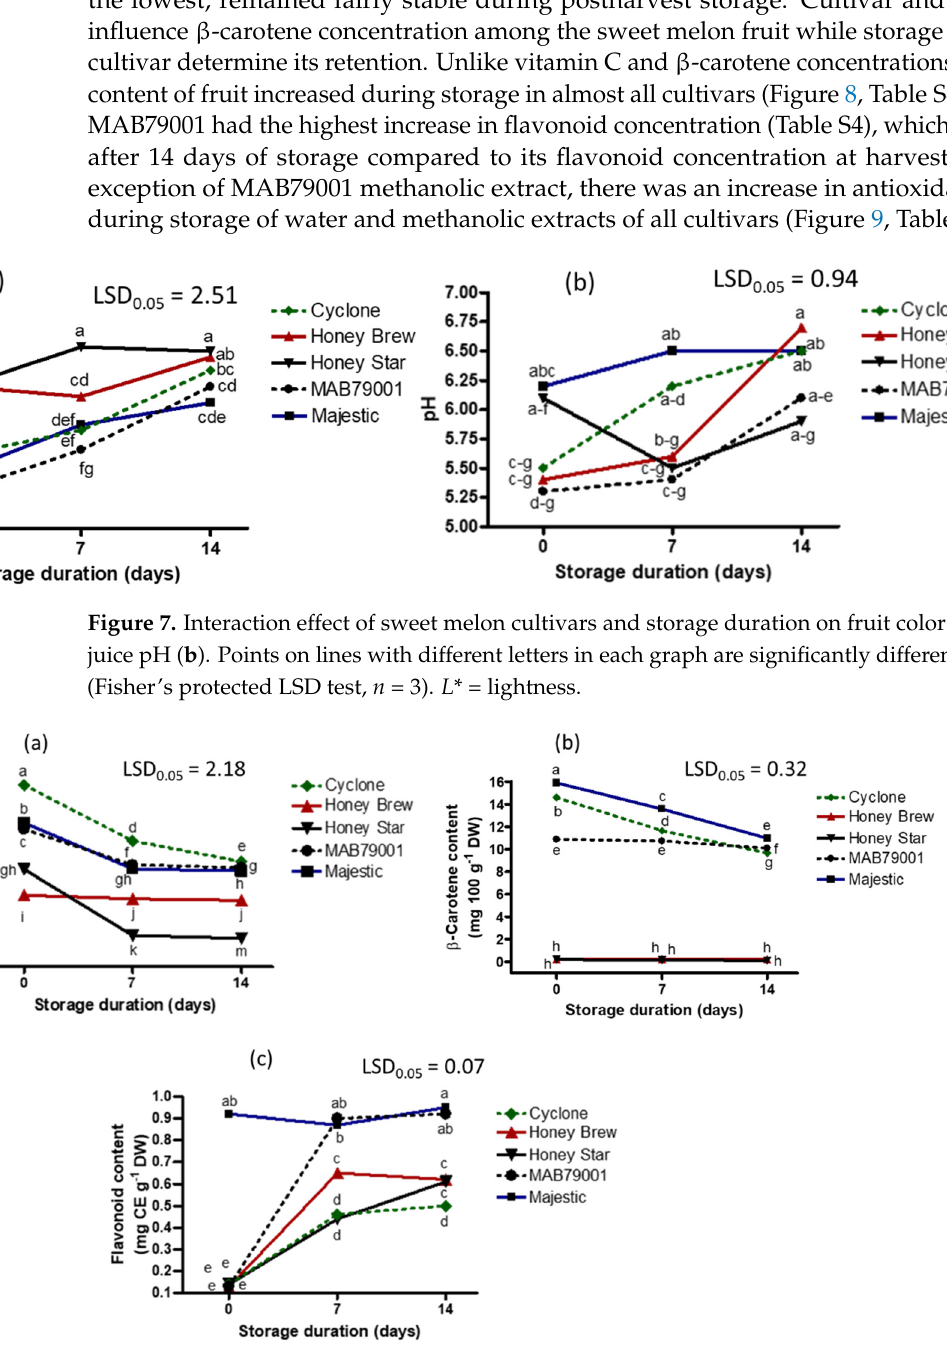
Figure 8. Interaction effect of sweet melon cultivars and storage duration on vitamin C ( a ), β -carotene ( b ) and flavonoid ( c ) contents. Points on lines with different letters in each graph are significantly different at p ≤ 0.05 (Fisher’s protected LSD test, n = 3). CE = catechin equivalent; DW = dry weight.